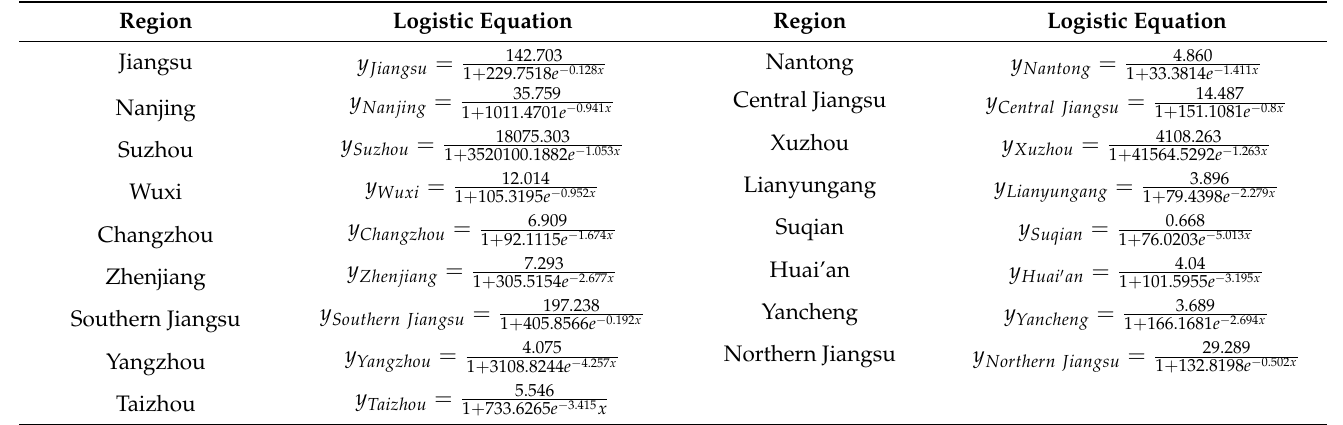
Table 3. Logistic equation of Jiangsu Province, Southern Jiangsu, Central Jiangsu, Northern Jiangsu and 13 prefecture level